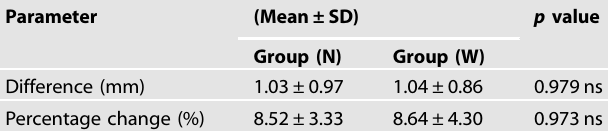
Fig. 6 Clinical photographs of 9 years old child presented with traumatized upper left central incisor enrolled in Group (W) showing clinical change in color that started to show at the 1 month follow up. a Baseline clinical photograph at second appointment, b Clinical photograph at 1 week follow up without discoloration, c Clinical photograph at 1 month follow-up showing shadow of cervical crown discoloration, d Clinical photograph at 3 months follow-up showing cervical crown discoloration, e Clinical photograph at 12 months follow- up showing cervical crown discoloration. f Clinical photograph showing composite buildup. Table 4. Mean and Standard deviation (SD) values for change in root length in (mm) and (%) in both